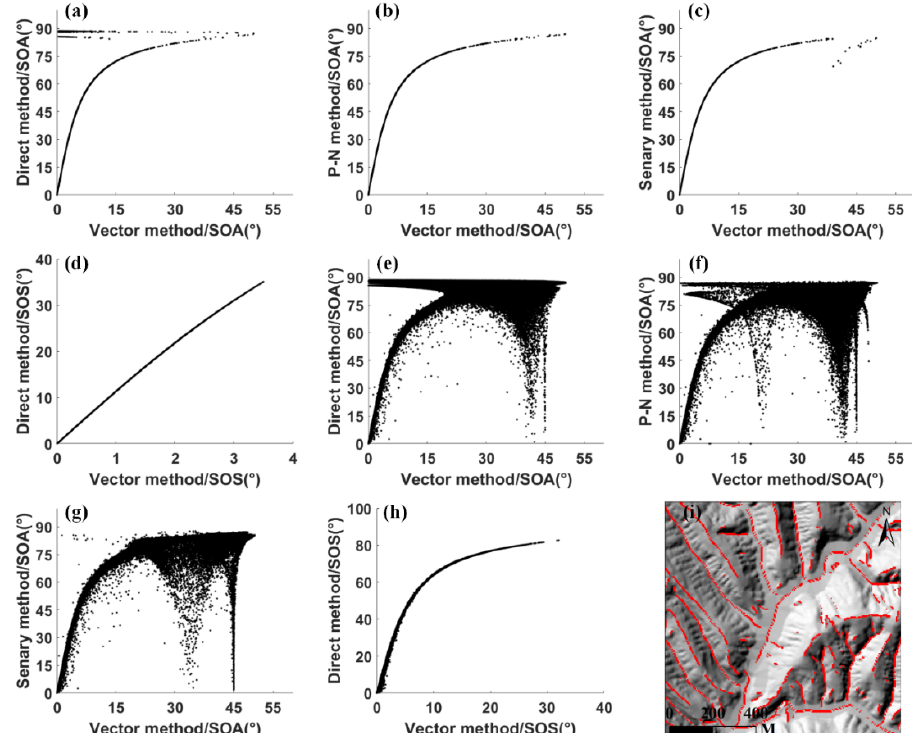
Figure 13. Scatterplots for SoA and SoS derived from different methods on Gaussian surface and real landform Suide TA1. Gaussian surface: SoA calculated by the ( a ) direct, ( b ) P-N, and ( c ) senary methods; SoS calculated by the ( d ) direct method. Real landform Suide TA1: SoA calculated by the ( e ) direct, ( f ) P–N, and ( g ) senary methods; SoS calculated by the ( h ) direct method. All these methods are compared with the vector method. Extractions ( i ) (red color) of range [30°, 46°] for SoA in Suide TA1.